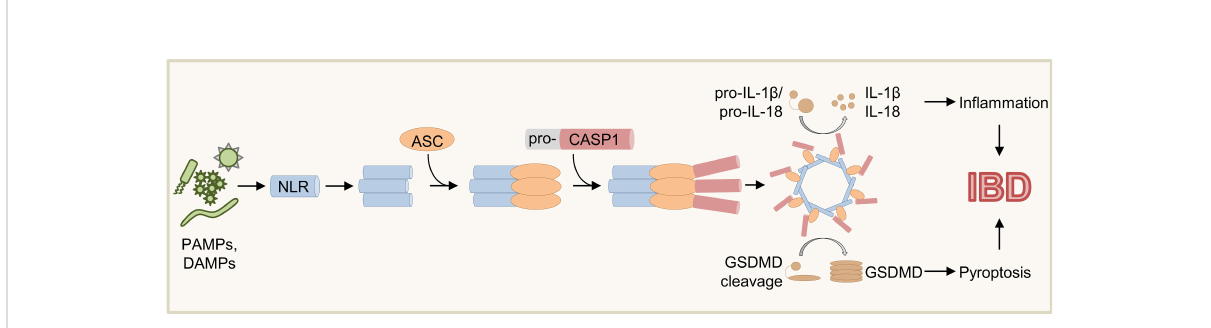
FIGURE 1 Schematic overview of in fl ammasome activation. Various PAMPs and DAMPs induce activation of sensor proteins resulting in oligomerization and recruitment of ASC and pro-CASP1. Upon autoproteolysis of pro-CASP1, mature CASP1 cleaves the in fl ammasome effector molecules pro- IL-1 b , pro-IL-18, and GSDMD, which induce in fl ammation and